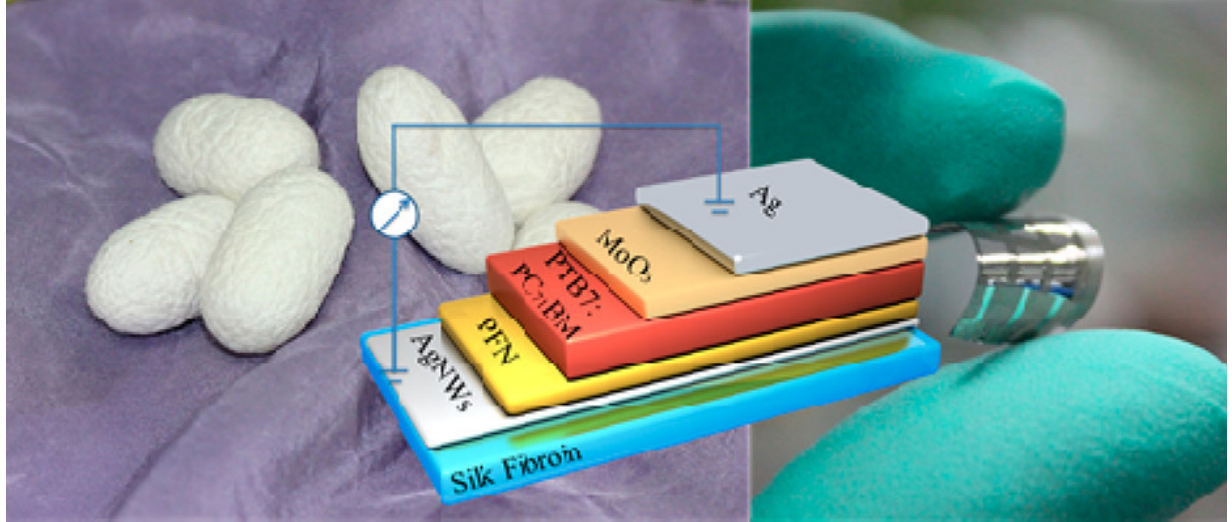
Figure 8. Bombyx Mori cocoons ( left ), schematic representation of the PV device ( centre ), and picture of the finished device ( right ). Here, PFN stands for poly[(9,9-bis(3 ′ -( N,N - dimethylamino)propyl)-2,7-fluorene)- alt -2,7-(9,9-dioctylfluorene)] and PTB7 stands for poly [[4,8- bis[(2-ethylhexyl)oxy]benzo[1,2-b:4,5-b ′ ]dithiophene-2,6-diyl][3-fluoro-2-[(2- ethylhexyl)carbonyl]thieno[3,4-b]thiophenediyl]]. Reprinted with permission from Ref. [60]. 2014, American Chemical Society.